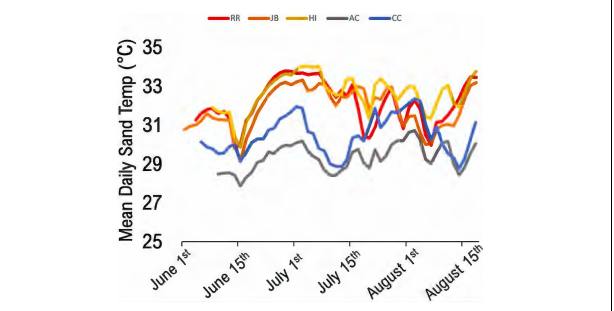
FIGURE 3 | Mean daily sand temperature profiles from 2020 control dataloggers. Gray and blue lines are north of the bioclimatic break in the warm-temperate regions. Red, orange, and yellow lines are south of the break (subtropical region) ( n = 112 days).